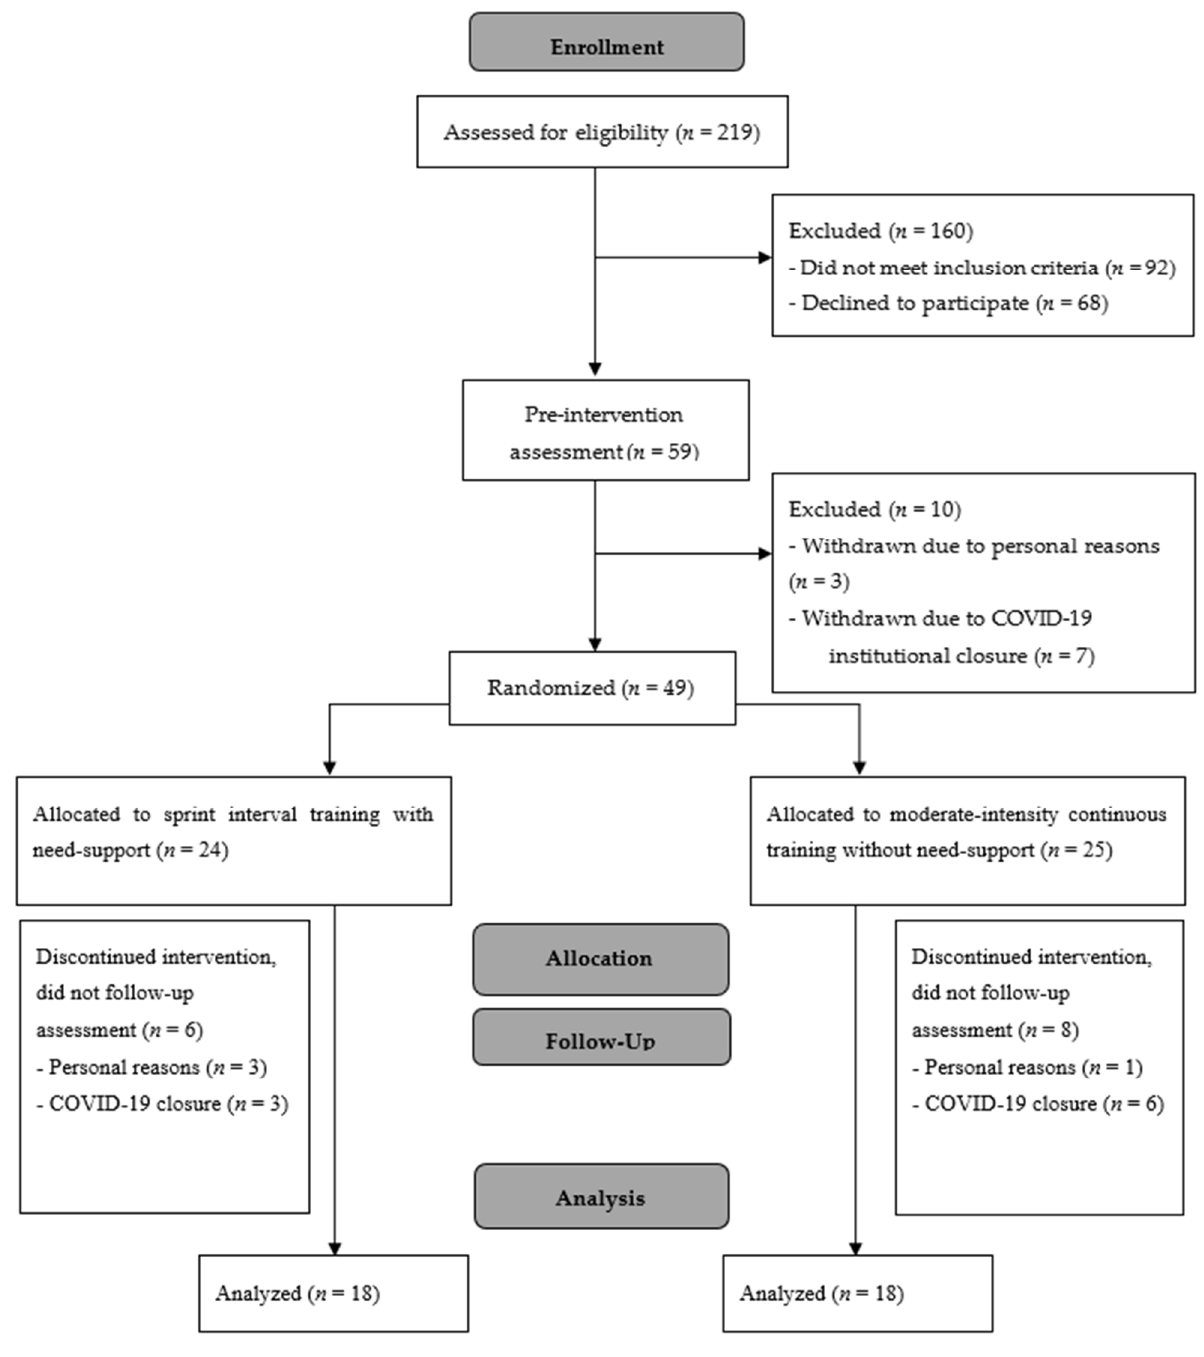
Figure 1. CONSORT flow diagram.